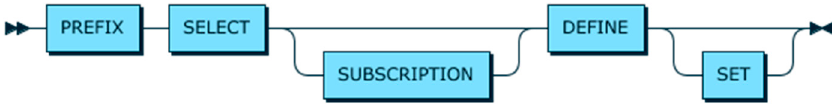
Figure 7. CQL production rule visualisation.